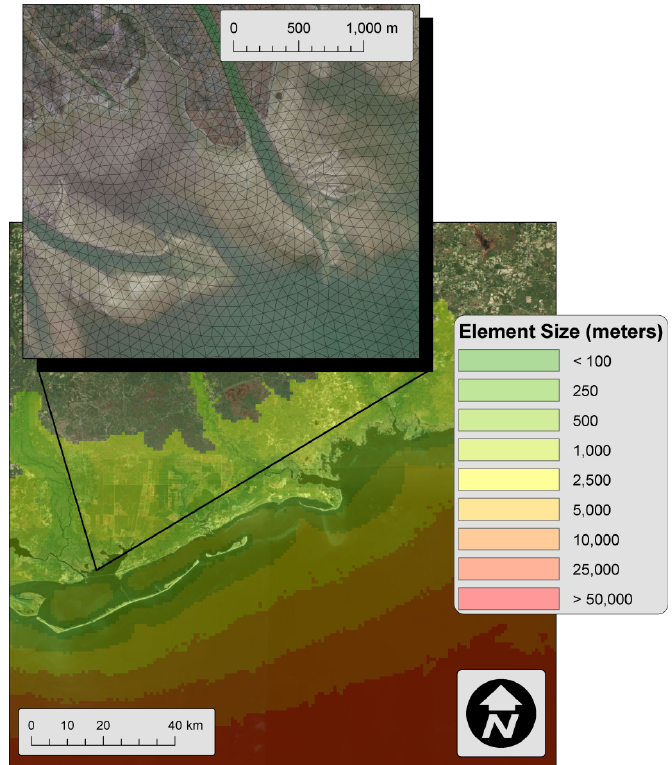
Figure 2. Mesh resolution across the tidal model focus area.